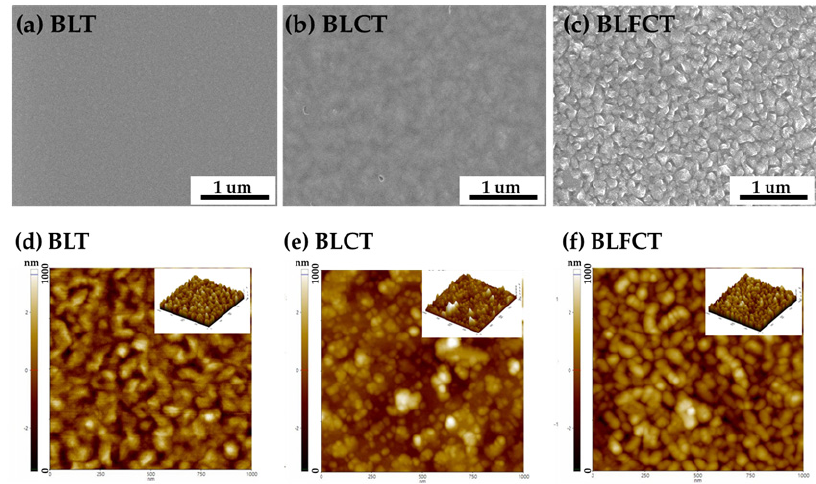
Figure 3. Surface morphologies (FE-SEM and AFM images) of the derived thin films; ( a , d ) BLT, ( b , e ) ( b , e ) BLCT, and ( c , f ) BLFCT. BLCT, and ( c , f ) BLFCT.